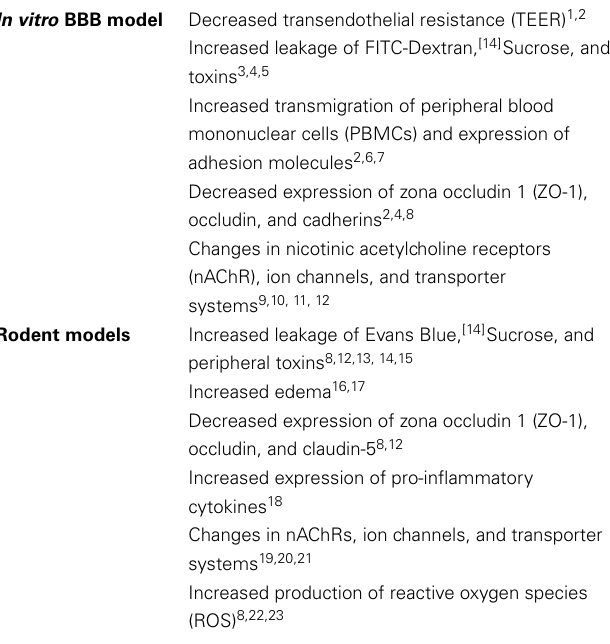
Table 4 | Summary of the preclinical and clinical literature on nicotine-induced BBB